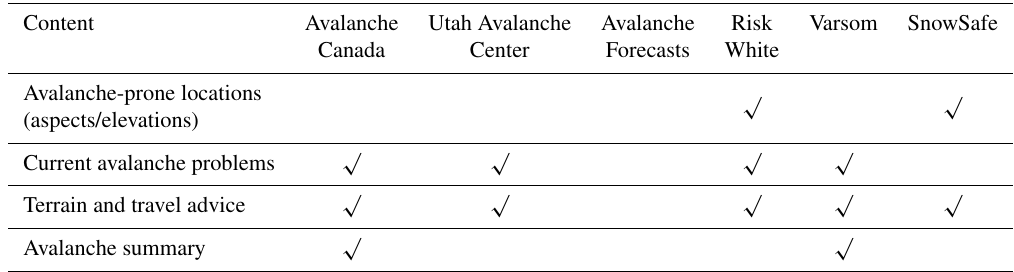
Table 3. Content available in smartphone applications: avalanche related information. smartphone